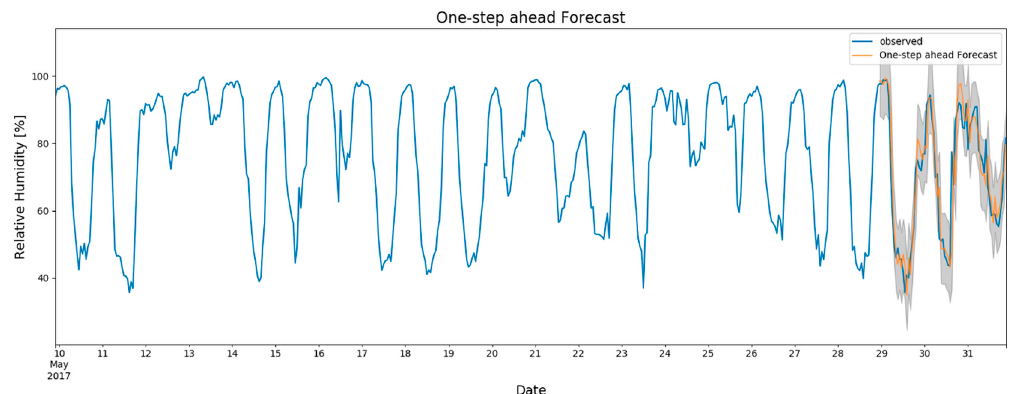
Figure 17. Training data and forecasting result for the relative humidity series obtained during the × (0, 1, 1) 24 model. IBIS measurements for the SARIMAX (1, 0, 1) × (0, 1, 1) 24 model. measurements for the SARIMAX (1, 0, 1)